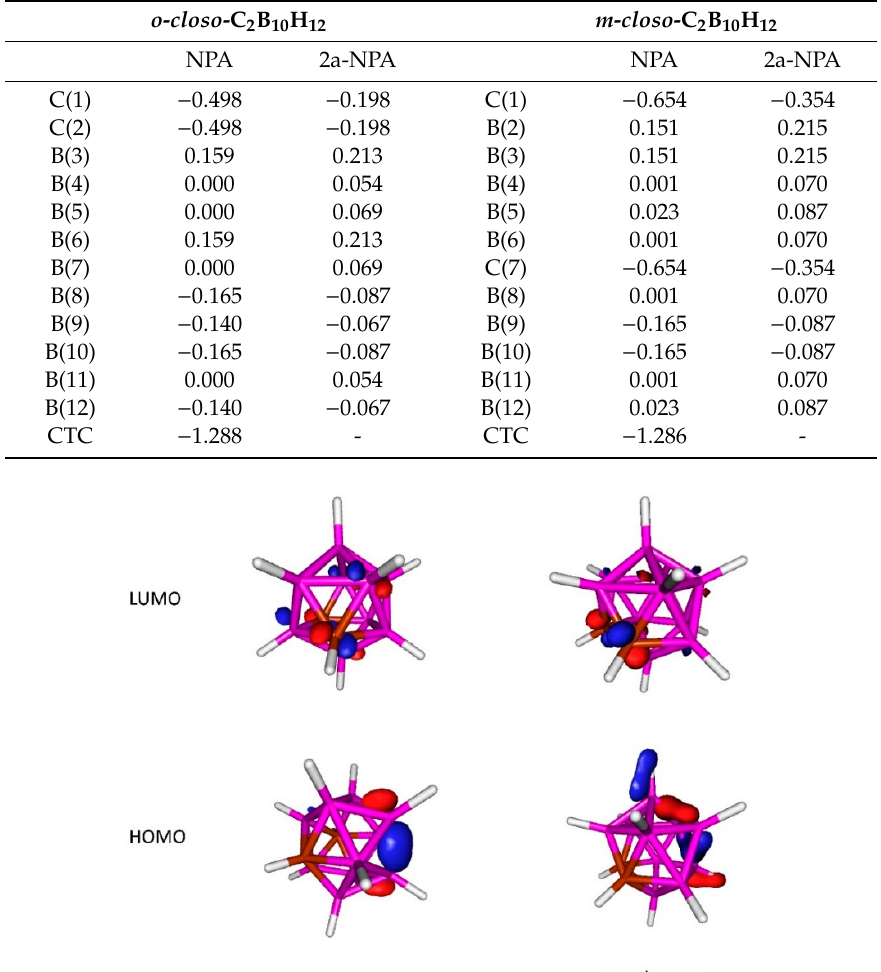
Table 1. Theoretical calculations of natural charges, 2a-NPA charges, and cumulative build-up of the cluster-only total charge (CTC) of ortho-closo and meta - closo carborane. See Figure 1 for the numbering of the clusters’ vertexes.